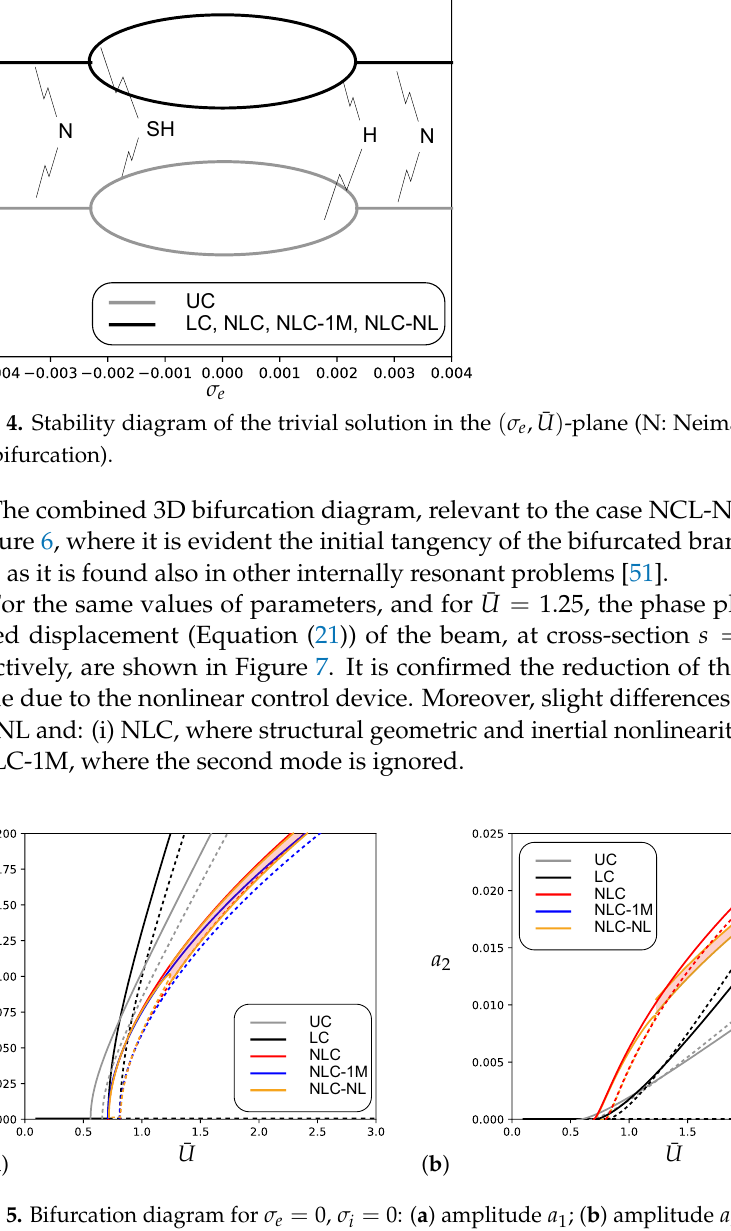
Figure 5. Bifurcation diagram for σ e = 0, σ i = 0: ( a ) amplitude a 1 ; ( b ) amplitude a 2 (solid line: stable; dashed line: